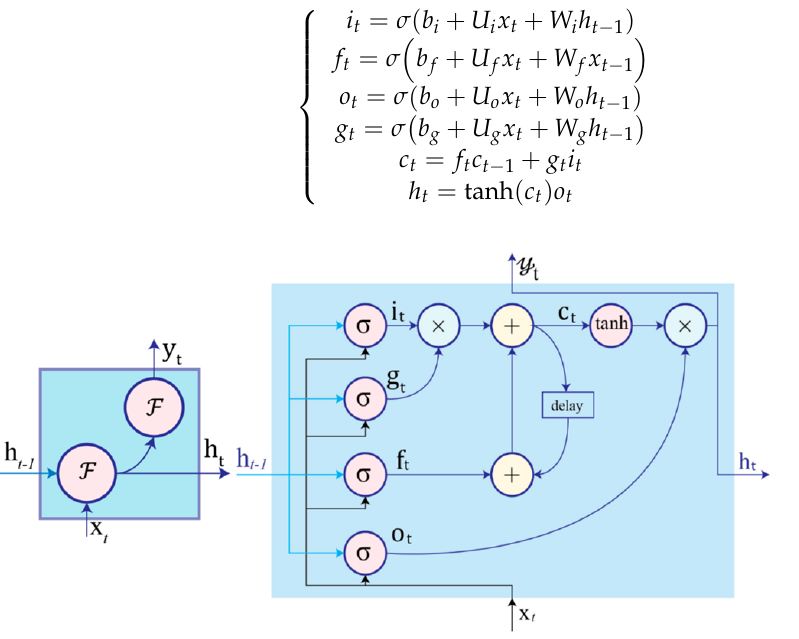
Figure 7. Schematic diagram of an RNN node and LSTM cell [202]. Left: RNN node where h t the previous hidden state, x t is the current input sample data, h t is the current hidden state, y t is the current output, and (cid:70) is the activation function. Right: LSTM cell with internal recurrence c t and outer recurrence h t